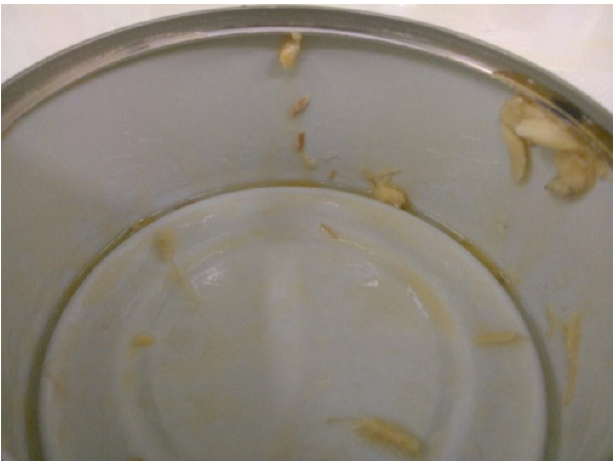
Figure 1. Muscle residues adhered to PET polymer after emptying the container. Areas of polymer coating with and without salmon adhesion.